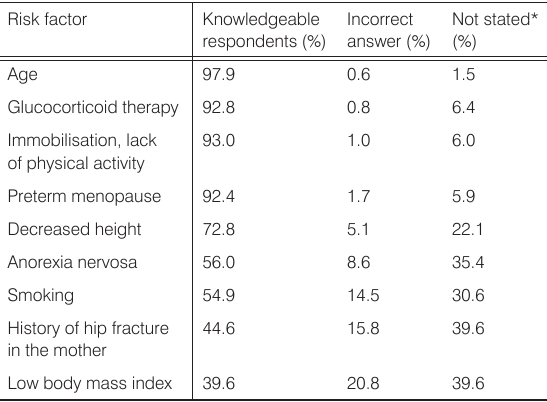
Table 1. Knowledge of risk factors for osteoporosis or osteoporo- sis-related fracture among 525 general practitioners in CZ Risk